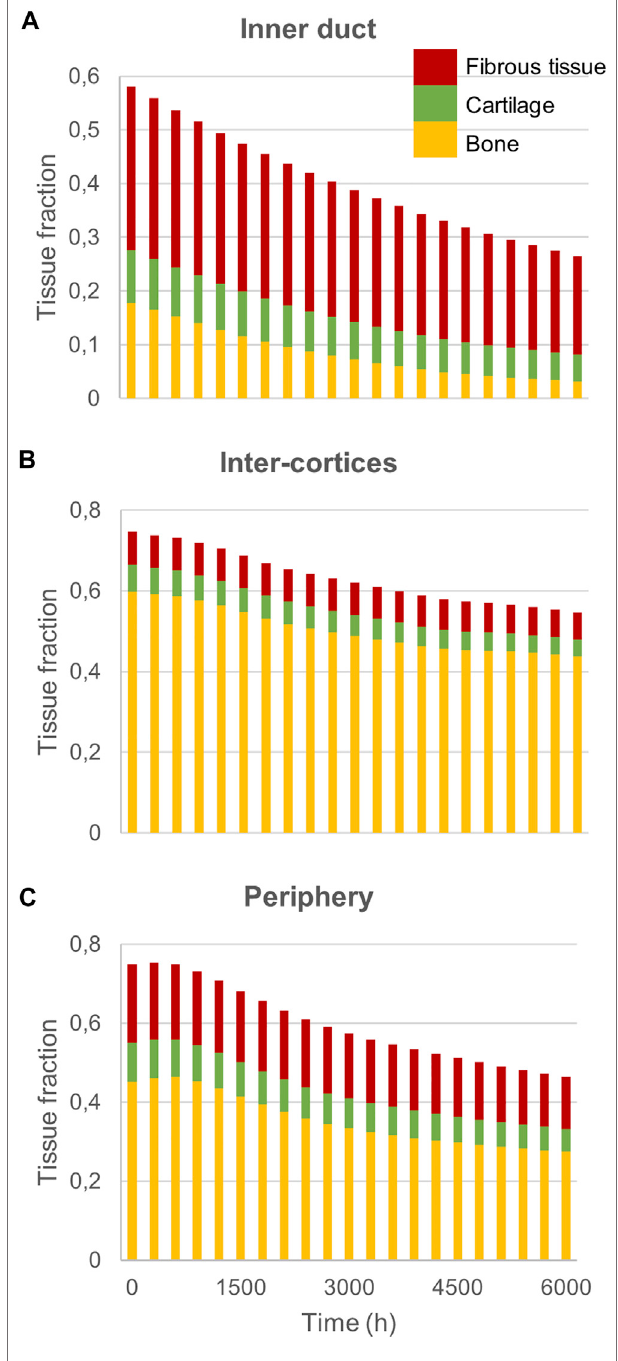
FIGURE 7 | Sheep fracture quanti fi cation: Mature bone, cartilage and fi brous tissue fraction evolution over time in (A) the inner duct; (B) the inter- cortices and (C) the